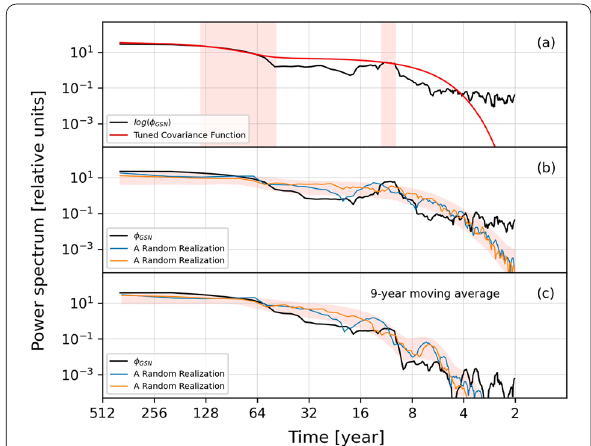
Fig. 6 Power spectrum of log ( φ GSN ) and φ GSN approximated by our tuned covariance function. a Compares the power spectrum of 0 and variance 1) log( φ GSN ) (black line, standardized to have mean = = with the theoretical spectral density of the tuned covariance function (red line). The tuning periods are highlighted with light red shading. Panel b compares the power spectrum of φ GSN (black line, standardized to have mean 0 and variance 1) with power = = spectrums of two random realizations (color lines) generated by the tuned covariance function for the period from 1610 to 2015 CE. The light red envelop indicates the estimated 95% confidence interval of the power spectrums from 1000 random realizations. c Is similar to panel b, but shows the power spectrum of a 9-year moving average version of φ GSN (black lines) and the power spectra of 1000 random realizations generated by the adapted covariance matrix (see text) for the same time period. All of the power spectra were computed with the Multitaper Method (bandwidth NΩ 8, tapers K = =